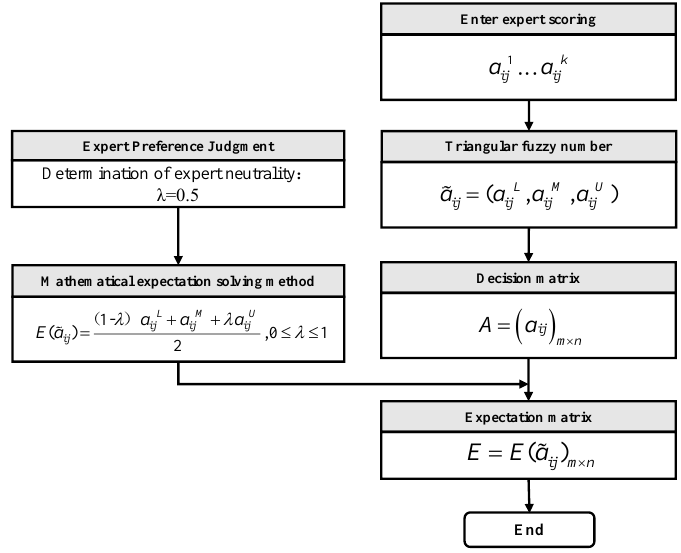
Figure 5. Non-technical attribute modeling method (expert scoring).